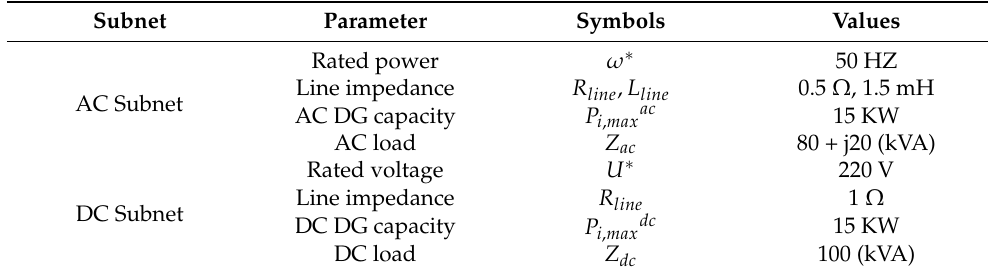
Table 2. Main parameters of the line.